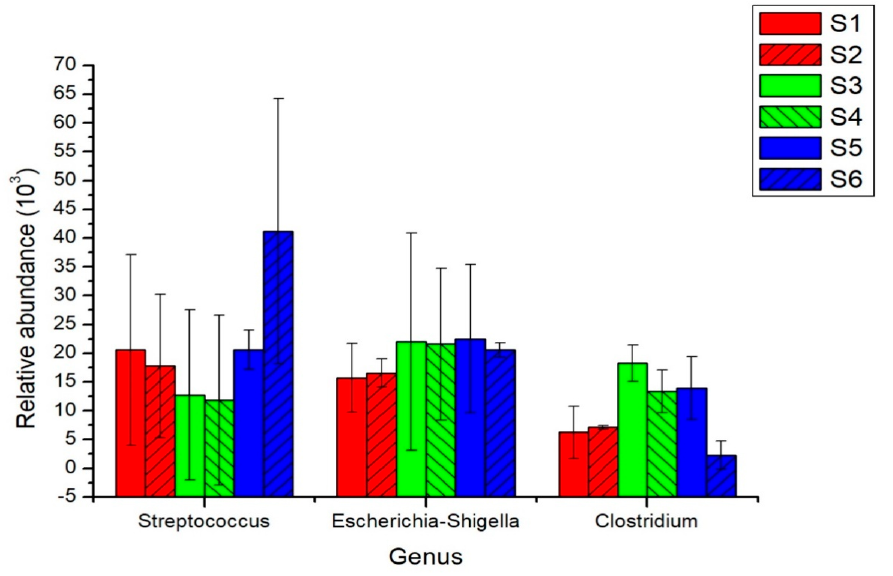
Figure 4. Abundance of three dominant bacteria in the gut of giant pandas at different develop- mental stages. Take the average of two experimental results in Aug (2017) and Feb (2018) of each